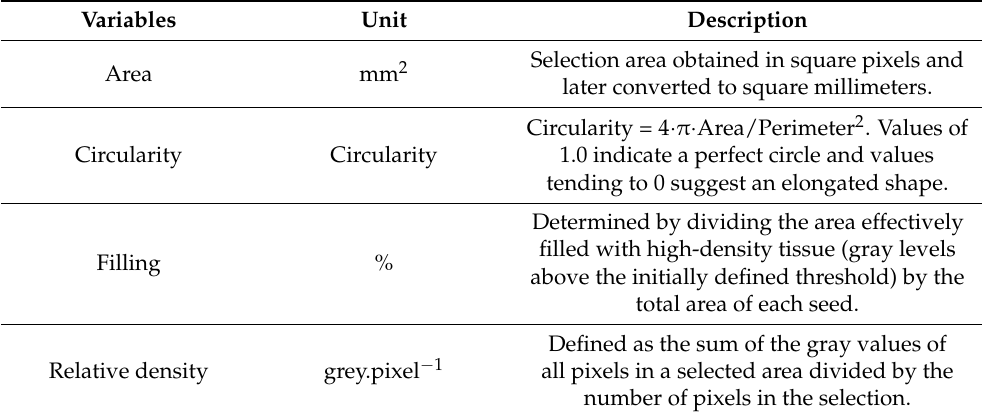
Selection area obtained in square pixels and later converted to square millimeters. Circularity = 4 · π · Area/Perimeter 2 . Values of 1.0 indicate a perfect circle and values tending to 0 suggest an elongated shape. Determined by dividing the area effectively filled with high-density tissue (gray levels above the initially defined threshold) by the total area of each seed. Defined as the sum of the gray values of all pixels in a selected area divided by the number of pixels in the